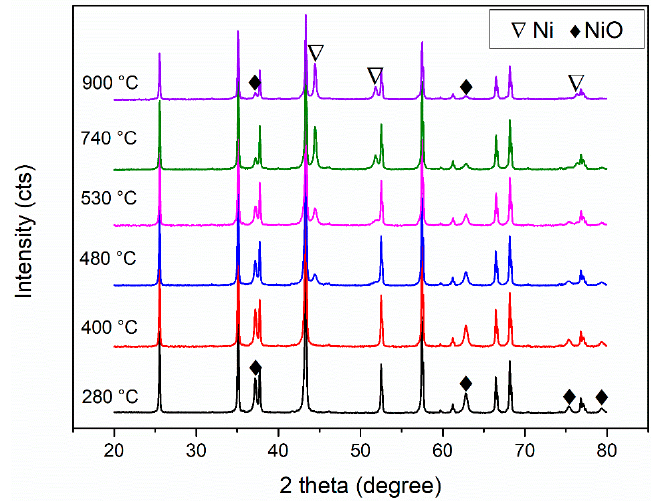
Figure 2. XRD profiles of the NA − C − T samples (T = 280, 400, 480, 530, 740, and 900, ♦ characteristic peaks of NiO, ∇ characteristic peaks of metallic Ni, and unmarked peaks are attributed to Al 2 O 3 ). Below 400 °C, citric acid was thermally decomposed, releasing CO 2 , H 2 O, and anhy-